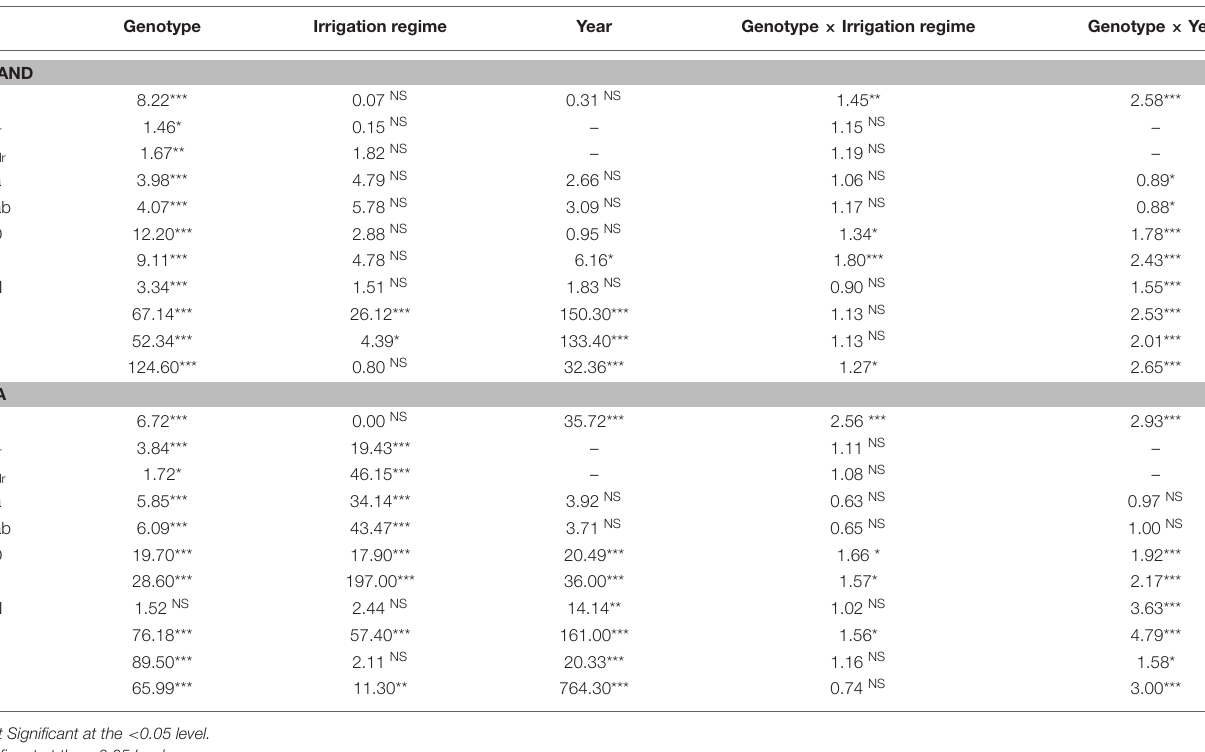
TABLE 2 | F -values and their associated significance values for selected fixed effects from an analysis of variance (ANOVA) for both the upland recombinant inbred line (RIL) and Pima populations for trait data collected from 2010 to 2012 at the Maricopa Agricultural Center. Trait